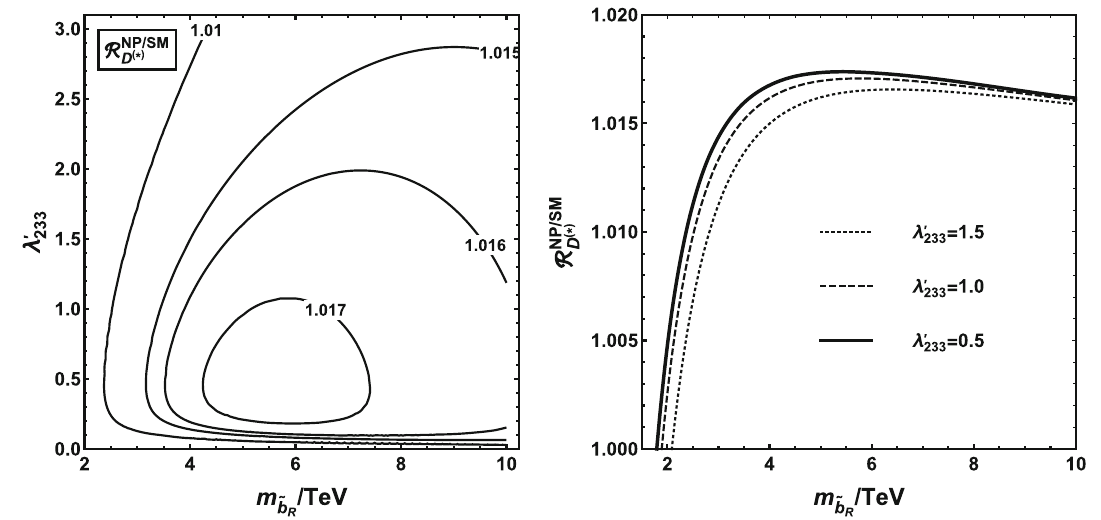
/ SM varies with m ˜ and λ (cid:3) in Case B. In the right panel, λ (cid:3) 233 b R D ( ∗ )